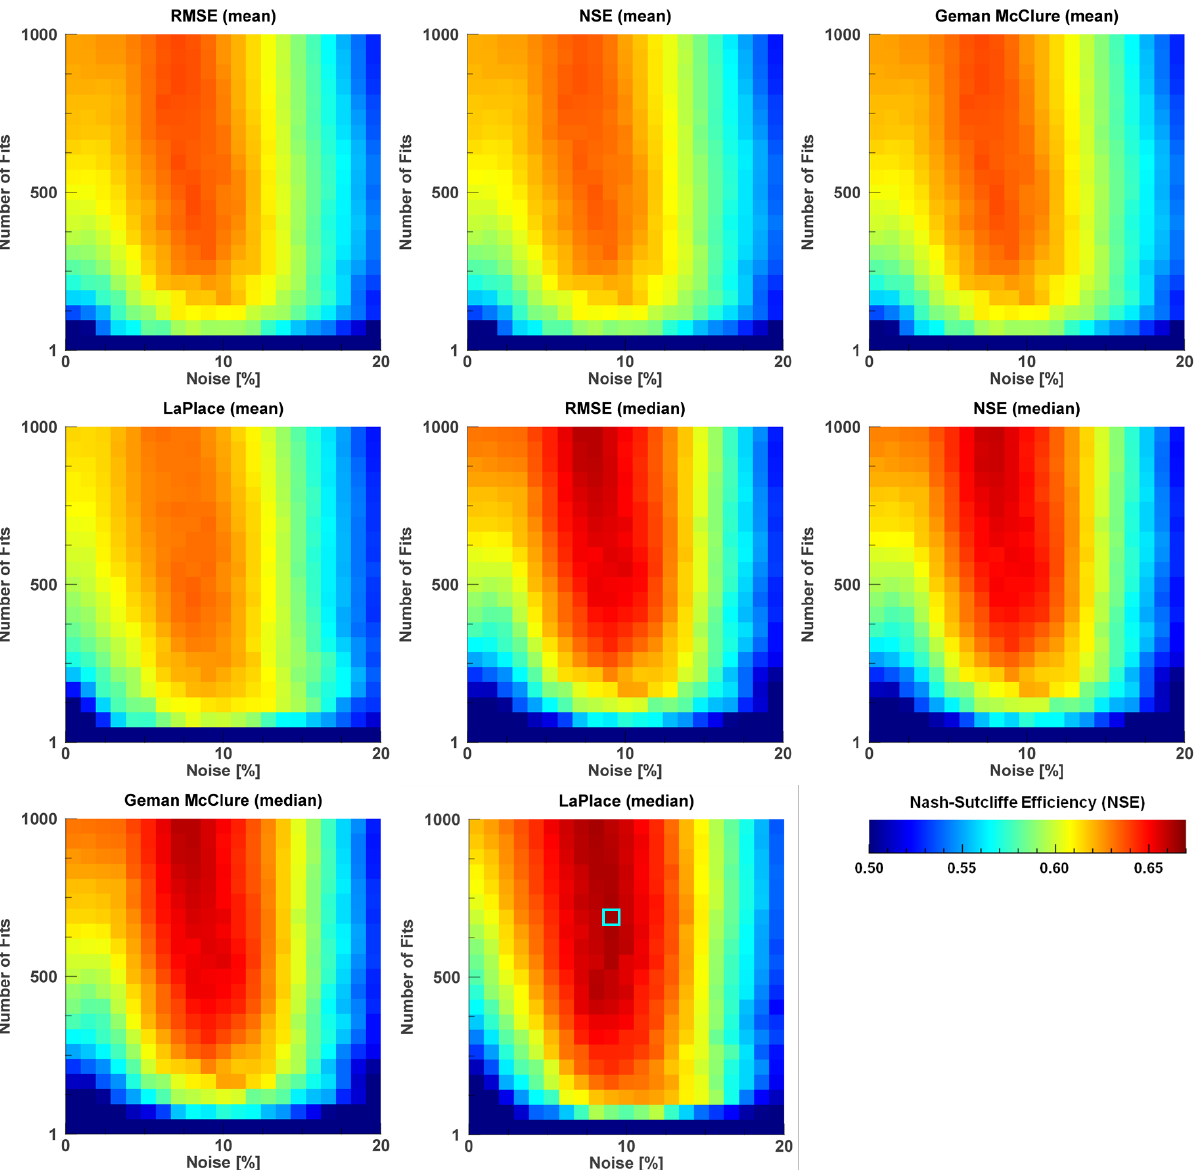
Figure 2. Accuracy matrices for the inverse-multiplicative noise type. The matrices are sorted by cost function/averaging method and show the estimation accuracy (NSE) for each combination of noise variance and number of considered best fits. The blue-marked square at the Laplace/median matrix represents the combination (σ = 9%, n = 700) with the highest accuracy among all possible combinations of selection criteria, including noise